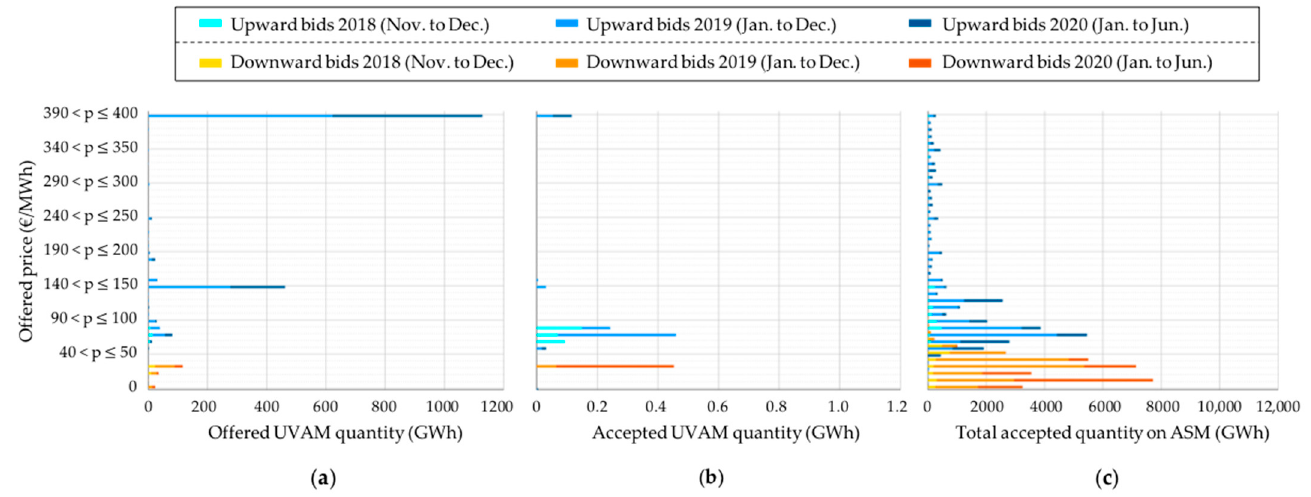
Figure 9. Comparison of offered and warded UVAM bids for ancillary services compared to overall market quantities by price range. ( a ) Offered UVAM bids; ( b ) awarded UVAM bids; ( c ) overall market quantities.